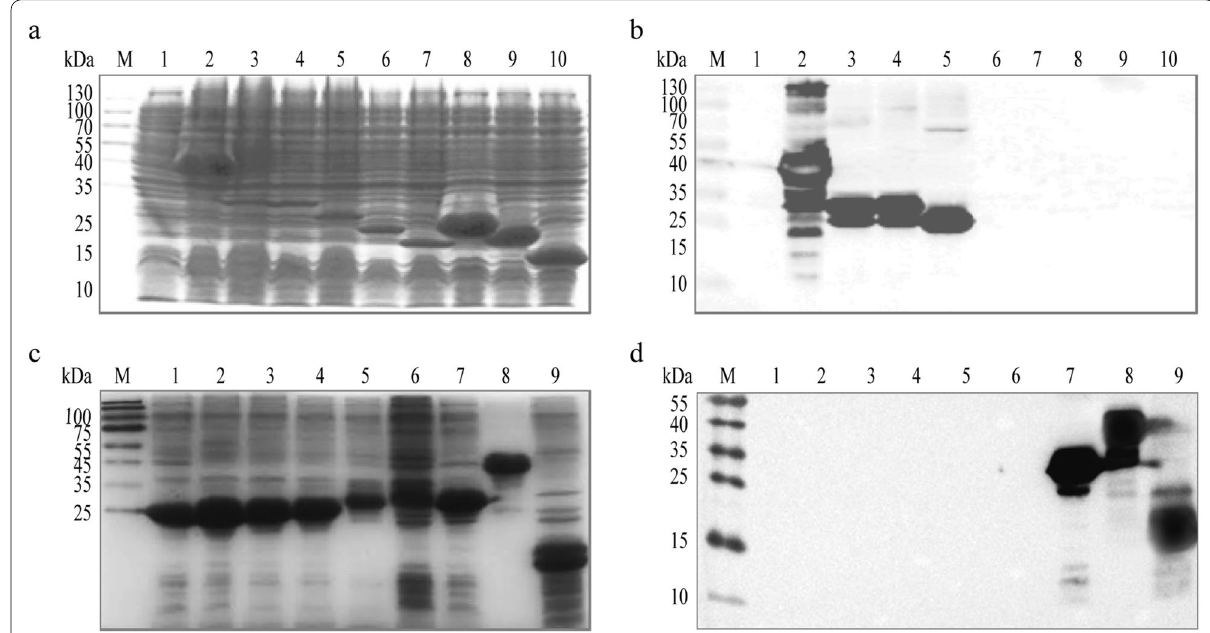
Fig. 3 Identification of antigenic epitope in Hexon of FAdV4 recognized by mAb 3G8.SDS-PAGE ( a ) and WB ( b ) analysis of the expression of truncated Hexon proteins. A series of hexon fragments were cloned into pET-30a ( ) and expressed in E. coli . Antigenic epitope of mAb 3G8 + was located between hexon657 and hexon540. 1, empty vector;2, hexon879; 3, hexon798;4, hexon750; 5, hexon657; 6, hexon540; 7, hexon375; lane 8, hexon459; lane 9, hexon405; 10, hexon312. SDS-PAGE ( c ) and WB ( d ) analysis of the expression of truncated Hexon proteins. A series of hexon fragments were cloned into pET-30a ( ) and expressed in E. coli . An epitope of “AYGAYVK” located between hexon636 and hexon657 was + characterized as the antigenic epitope recognized by mAb 3G8. 1, hexon540; 2, hexon570; 3, hexon582; 4, hexon600; 5, hexon615; 6, hexon636; 7,